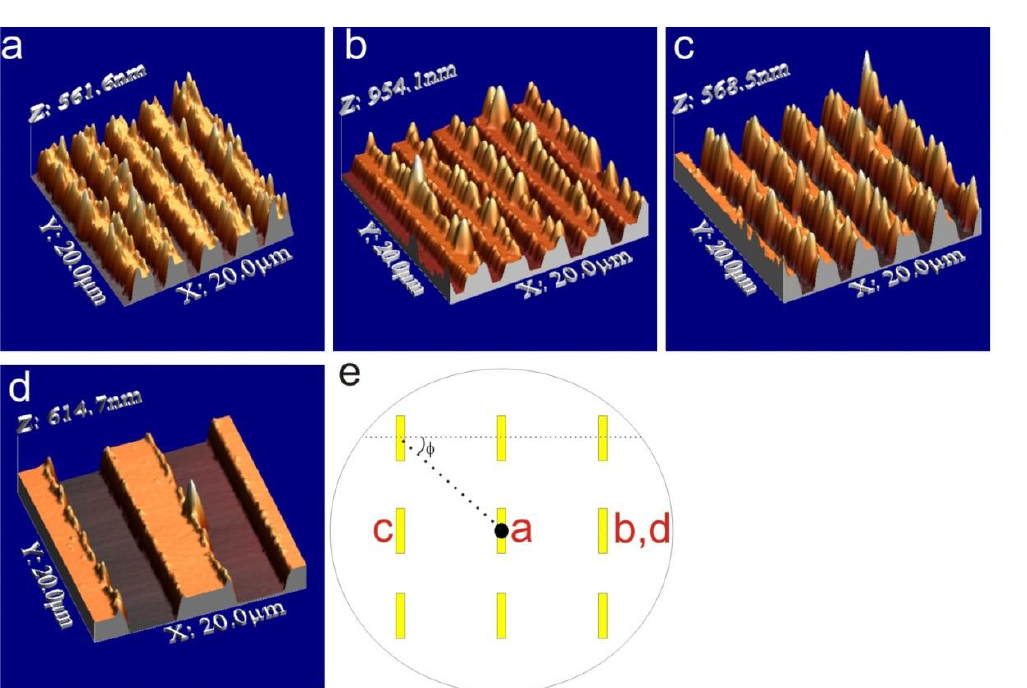
Figure 3. 3D reconstruction of AFM images showing the formed lift-off ears. ( a ) 2 µm width structures at the middle of the wafer; ( b ) 2 µm width structures at one edge of the wafer; ( c ) 2 µm width structures at the opposite edge of the wafer relative to (b); and ( d ) 5 µm width structures at the right side of the wafer; ( e ) Schematic of the metal evaporation process that is thought to cause the uneven distribution of the height of the lift-off ears. The letters mark the location at which the images (a)–(d) were